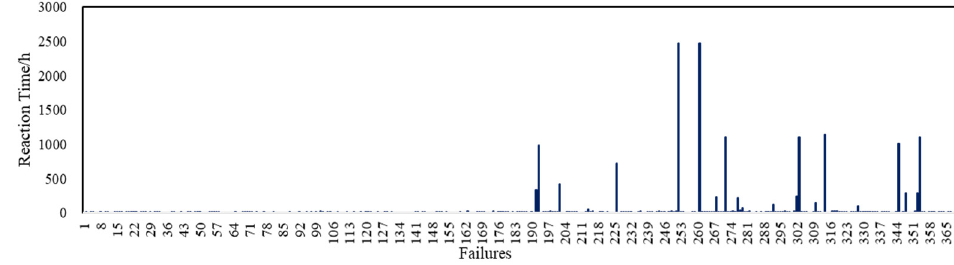
Figure 9. RTs of the maintenance of the 375 failures.